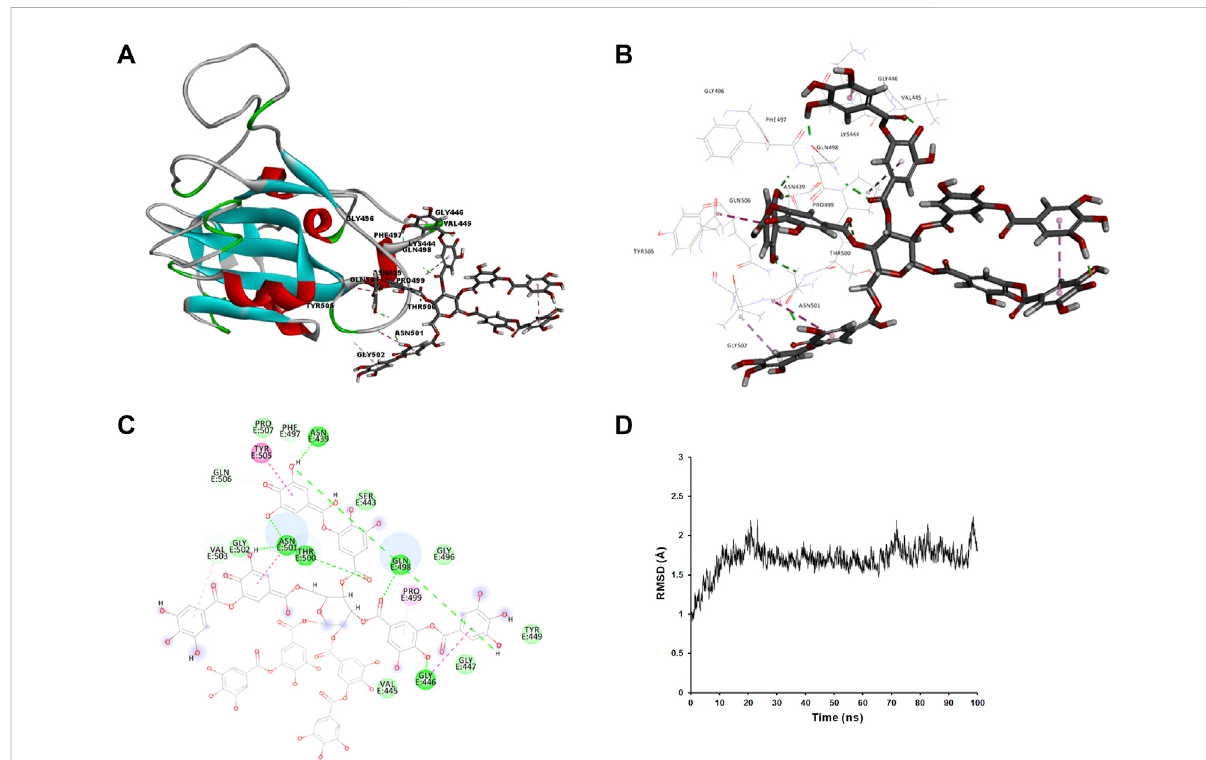
FIGURE 5 Molecular interaction of tannic acid with SARS-CoV-2-RBD. Tannic acid and key residues were shown as sticks with carbon, oxygen and nitrogen colored gray, red and blue, respectively. Electrostatic interaction was shown as dashed lines with π - π , π -alkyl, and hydrogen bonds colored purple, pink, and green, respectively. (A) Binding feature of tannic acid with S-RBD. Secondary structural elements are depicted as ribbons (coils, α -helices; arrows, β -sheets). Color is based on secondary structures ( α -helices, red; β -sheets, sky-blue; loops, green). (B) Molecular interaction of tannic acid with the residues of S-RBD. The residues were shown in sticks and labeled in black. (C) Molecular interaction schemes of tannic acid with the residues of S-RBD. (D) MD simulation of tannic acid in complex with S-RBD. The selected pose was subjected